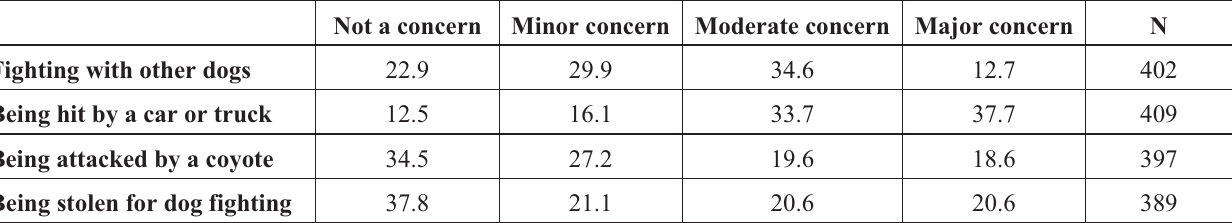
Table 7. Non-pet owners’ responses to: “Please indicate how concerned you are that the following could happen to dogs that are unsupervised and off-leash in the D.C. metro area.” Given in percentages.